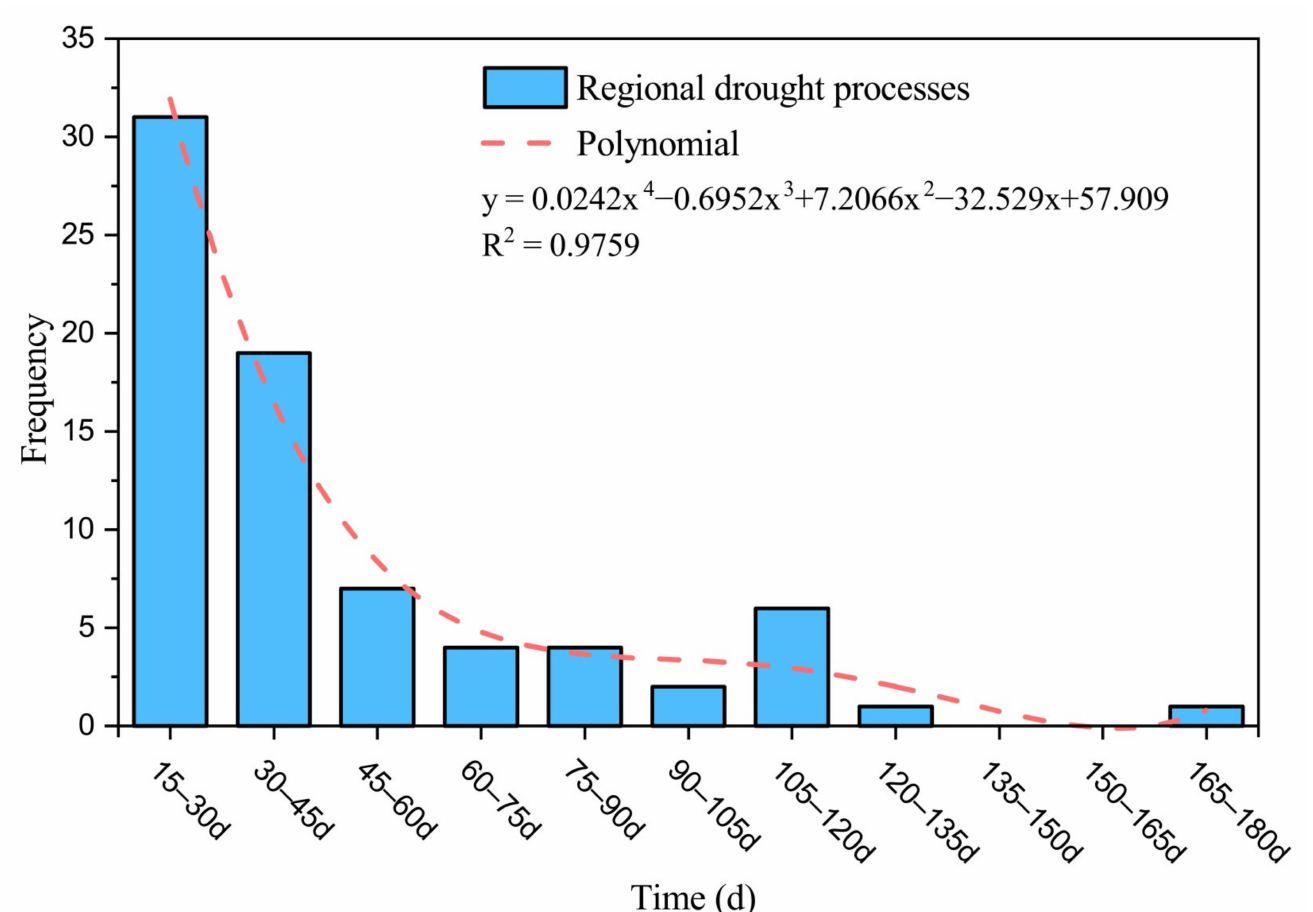
Figure 7. Frequency distribution of regional drought processes in North China from 1960 to